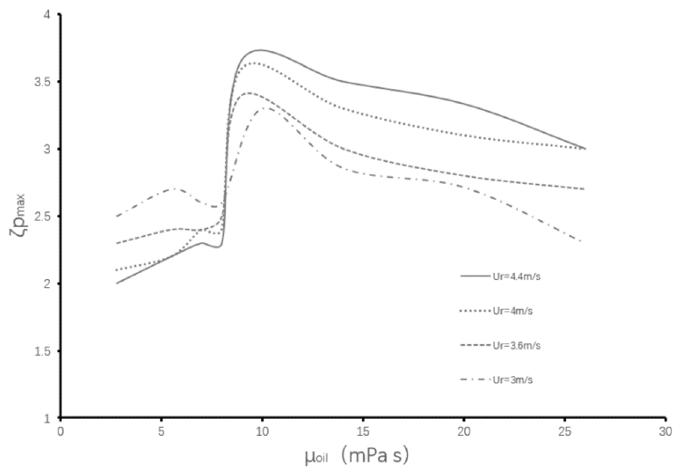
Figure 10. Change in ζ pmax with the oil phase’s viscosity and the collision